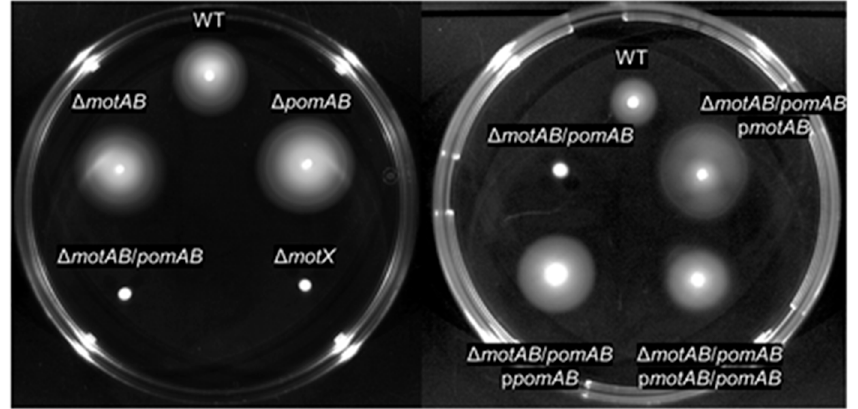
Figure 1. Motility phenotypes on the soft-agar plate. Bacteria were inoculated on LB plates containing 0.25% agar. Plates were incubated at 37 °C and observed at 24 h post-inoculation.